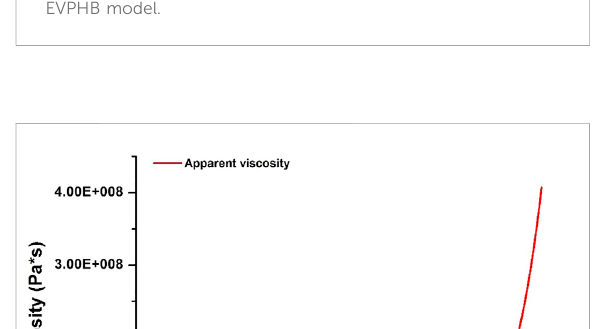
FIGURE 10 Stressrelaxationunderconstantboundarystrainproducedby EVPHB model.